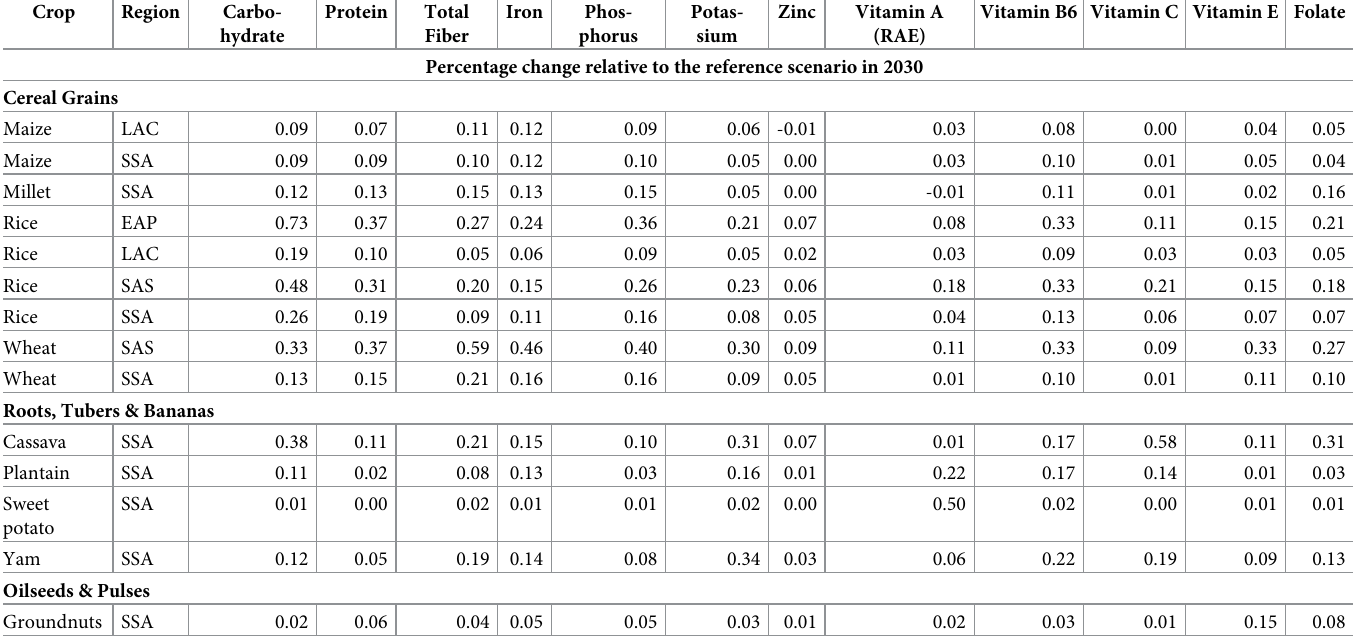
Table 10. Change in selected nutrient adequacy ratios in 2030 from faster productivity